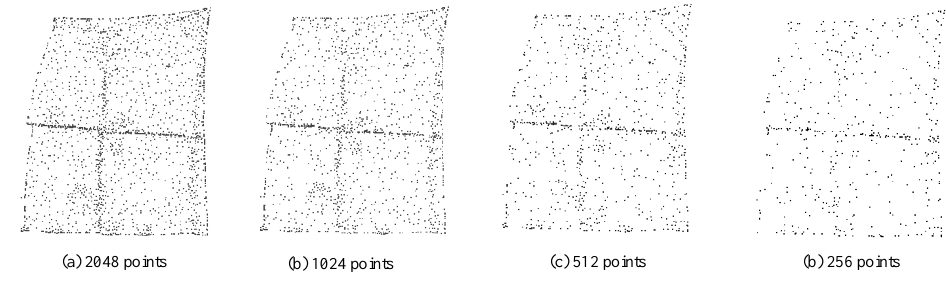
Figure 6. Point cloud patches with different scales.